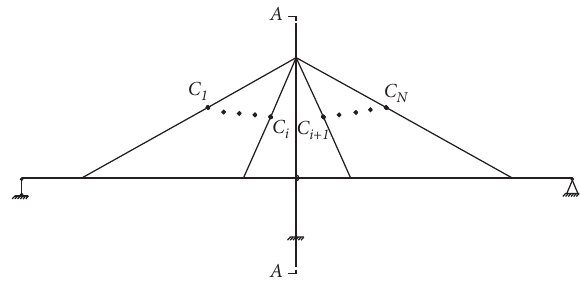
Figure 1: The simplified model for cable-stayed